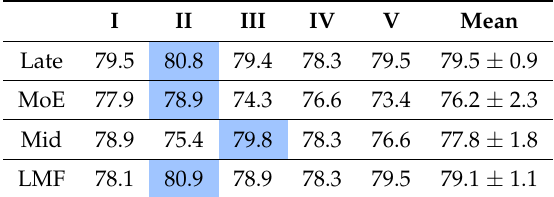
Table 3. The comparison of four fusion methods performed on the Penn Haptic Texture Toolkit (HaTT) dataset.